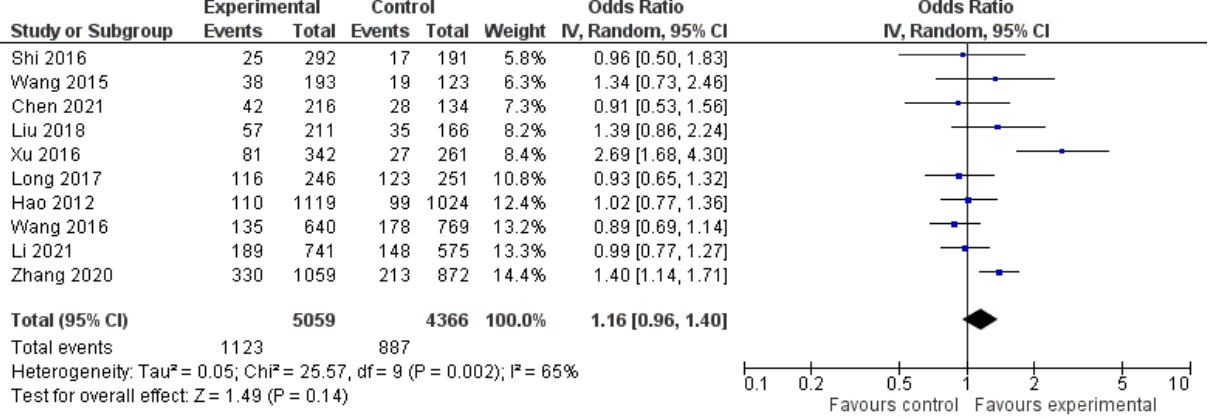
Figure 3. Forest plot of the metastatic lymph nodes harvested.